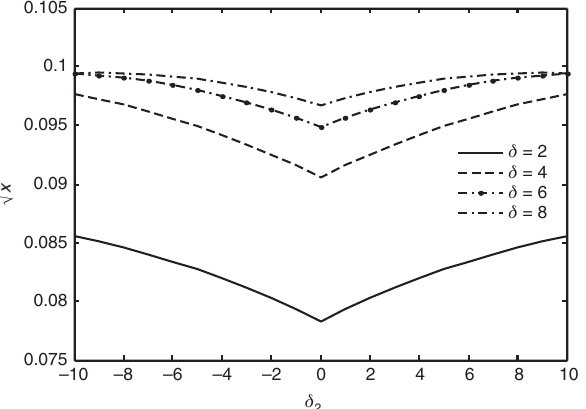
Figure 12: Variations of non-dimensional phase speed ( ) x against rotation parameter Ω = −5. and δ 2